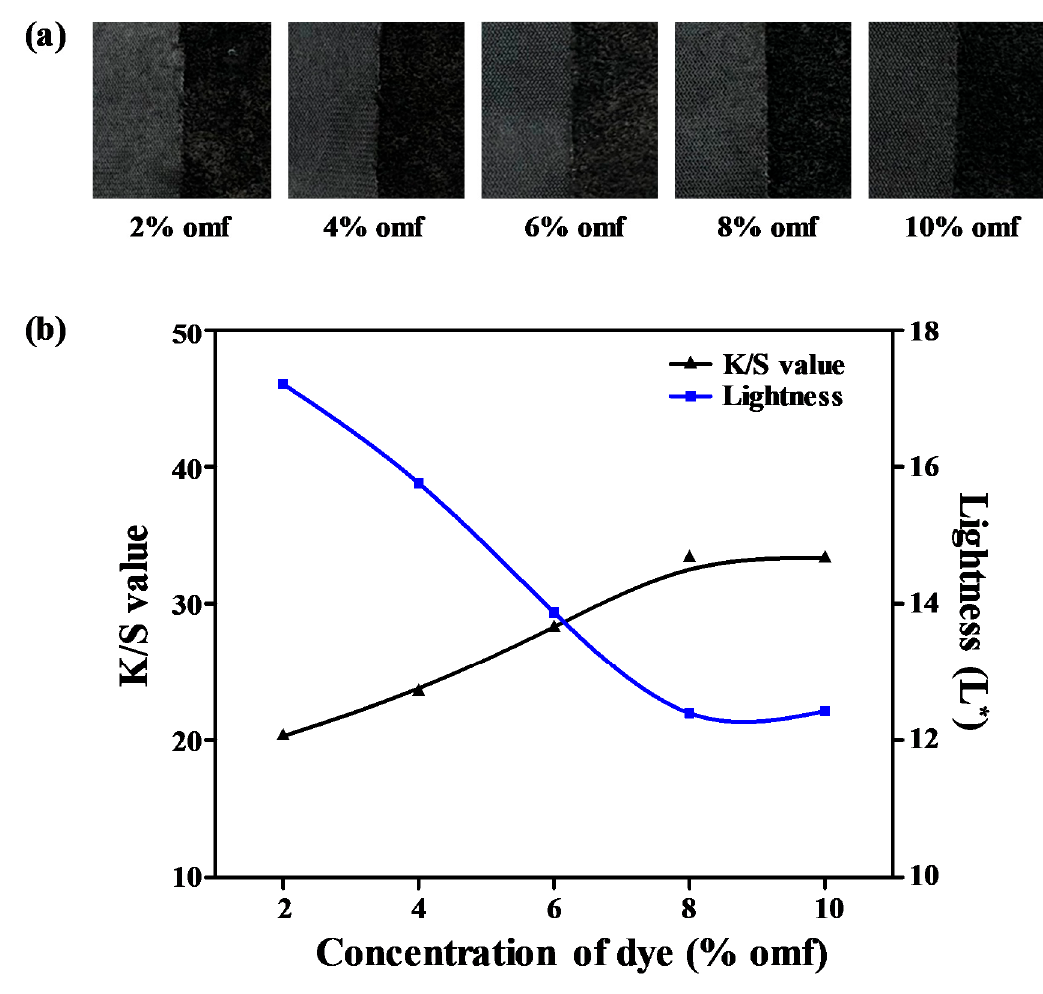
Figure 6. ( a ) Dyed samples. ( b ) K / S and lightness (L*) values according to dye concentration (2–10% omf).